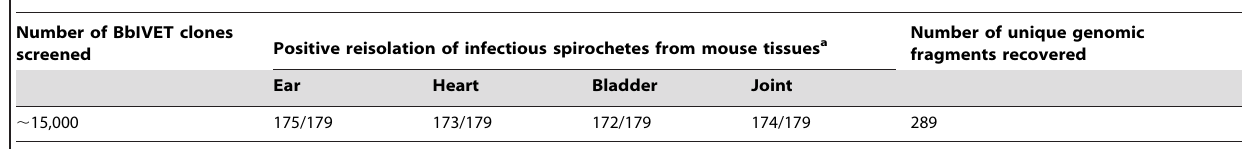
Table 2. The B. burgdorferi IVET system selects for in vivo -active